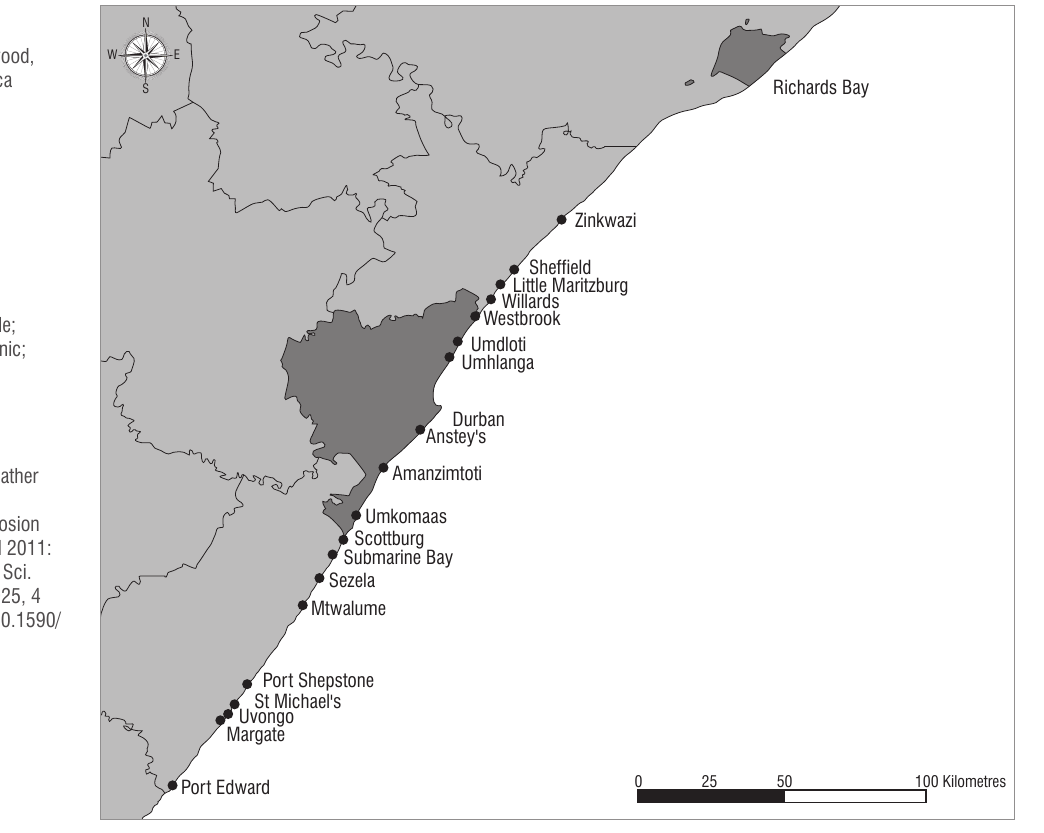
Figure 1: Map showing the location of erosion hotspots along the KwaZulu-Natal coast. Knowledge of where and when erosion will strike is vital to coastal managers. 8 Recent work 9 has highlighted